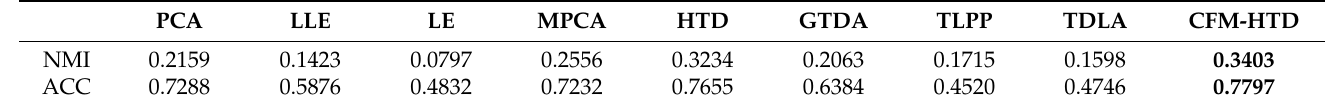
Table 3. ACC and NMI of different multisource fusion methods using dataset 2.